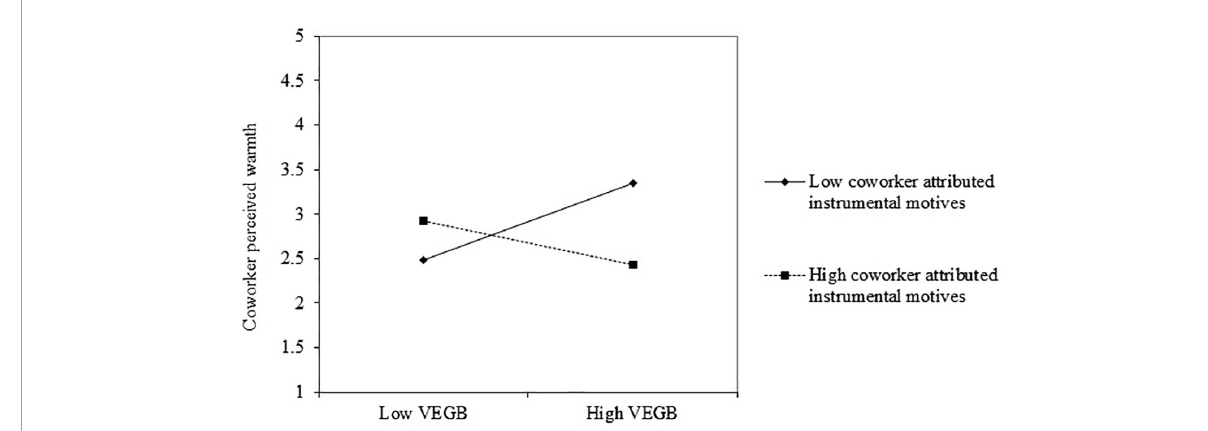
FIGURE2 The interactive effect of VEGB coworker-attributed instrumental motives on perceived warmth.